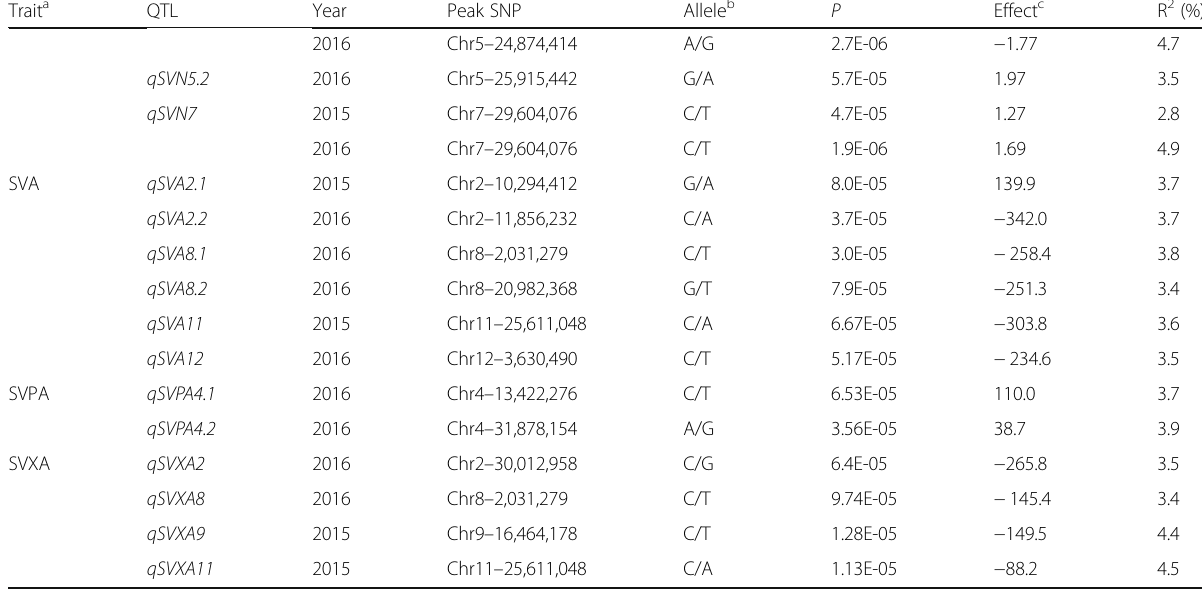
Table 1 QTL identified for eight peduncle vascular bundle related traits in two years (Continued) Trait